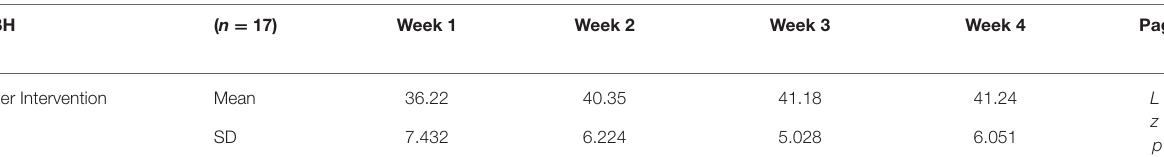
FIGURE 6 | Perceived Stress Scale 4. TABLE 7 | Relationship with the Dog Handler.